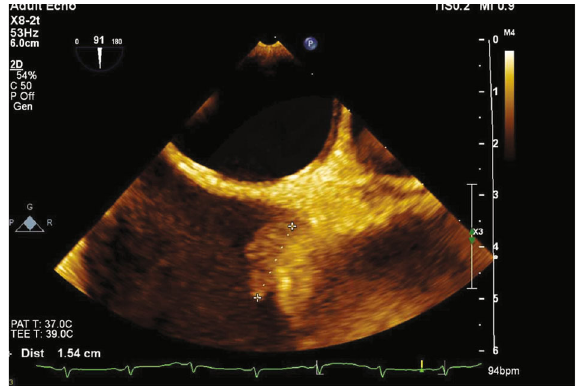
Figure 2: Transesophageal echocardiogram showing a mobile lesion at the junction of the SVC and right atrium. The lesion is irregular and measures about 1.7cm in greatest